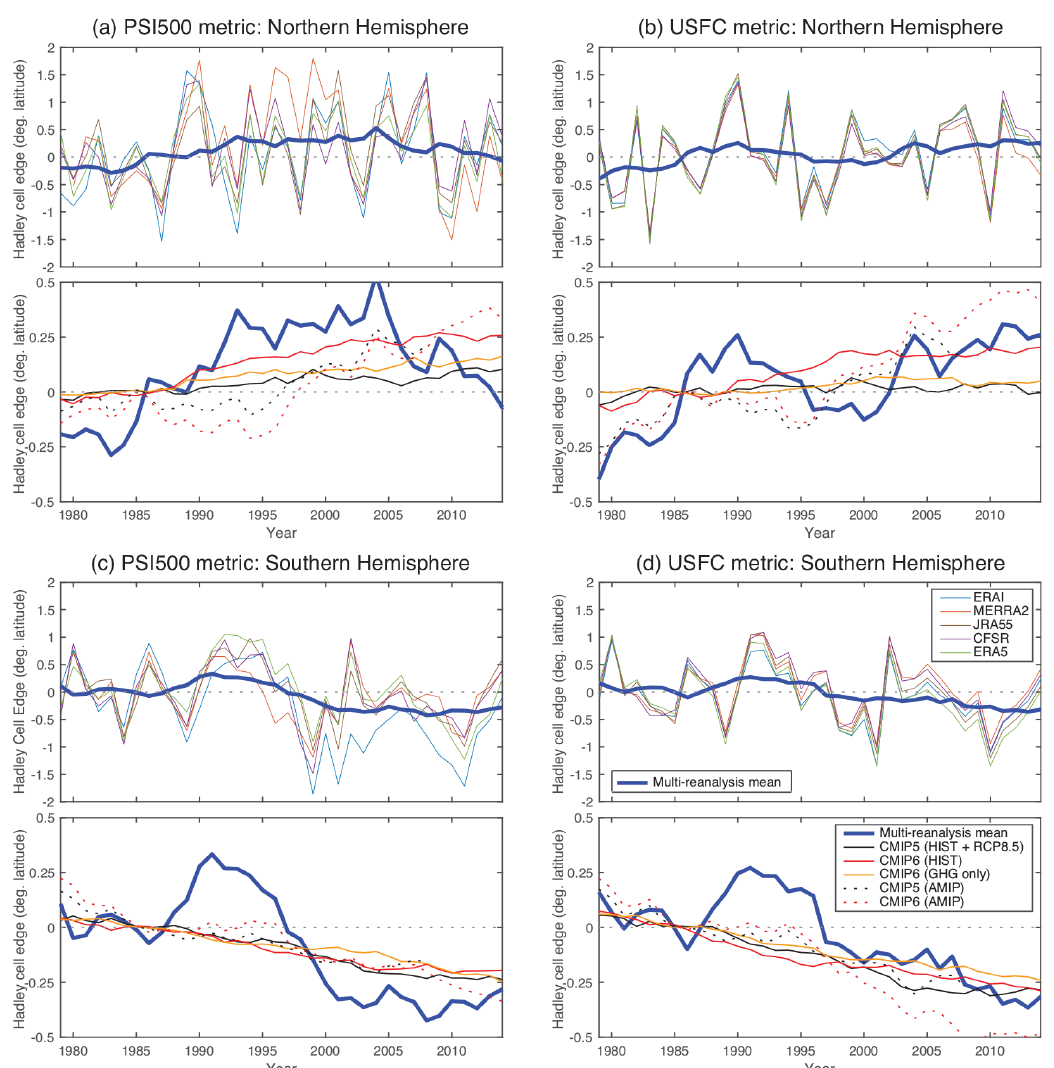
Figure 5. The 1979–2014 time series of annual-mean Hadley cell edge latitude, as measured by the (a, c) PSI500 and (b, d) USFC metrics. All time series are plotted with respect to their 1980–1990 average. The top set of time series in each panel shows five reanalyses (ERA- Interim, MERRA-2, JRA-55, CFSR, and ERA5), along with the multi-reanalysis mean (thick blue line). The bottom set of time series in each panel shows the multi-reanalysis mean (thick blue line, reproduced from the plot above) as well as the multi-model mean from (black) CMIP5 historical runs (extended with RCP 8.5 until 2014), (red) CMIP6 historical runs, (orange) CMIP6 historical greenhouse-gas-only runs (using all available ensemble members; see Table S2), (black dashed) CMIP5 AMIP runs, and (red dashed) CMIP6 AMIP runs. The reanalysis-mean and multi-model mean time series are smoothed with a 10-year running mean to better visualize the low-frequency variability in each time series. Note that the scale is different for the top and bottom sets of time series in each